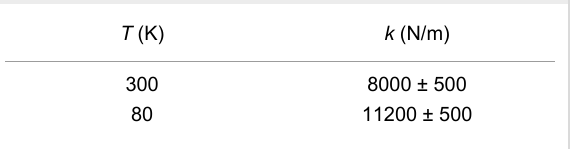
Table 2: Spring constants measured by thermal fluctuations. All measurements were performed with Torr Seal as the glue.